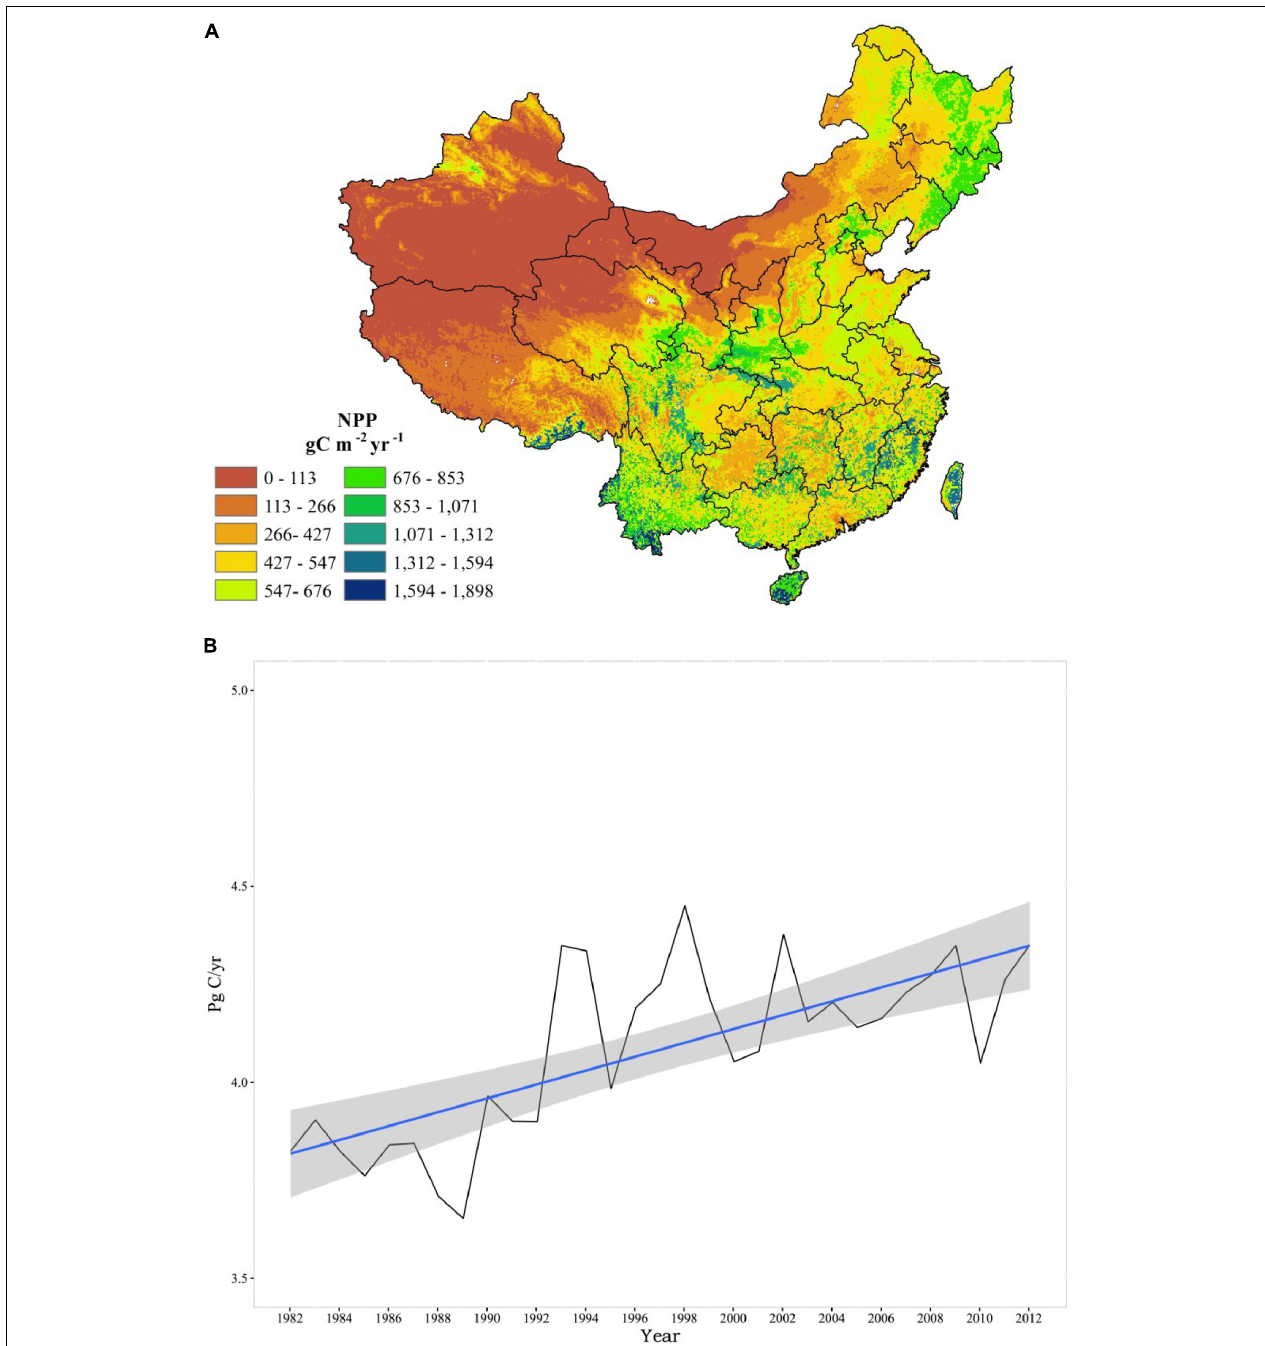
FIGURE 3 | (A) The spatial distribution of annual mean NPP in China from 1982 to 2012 and (B) the timeseries of total annual NPP in China.